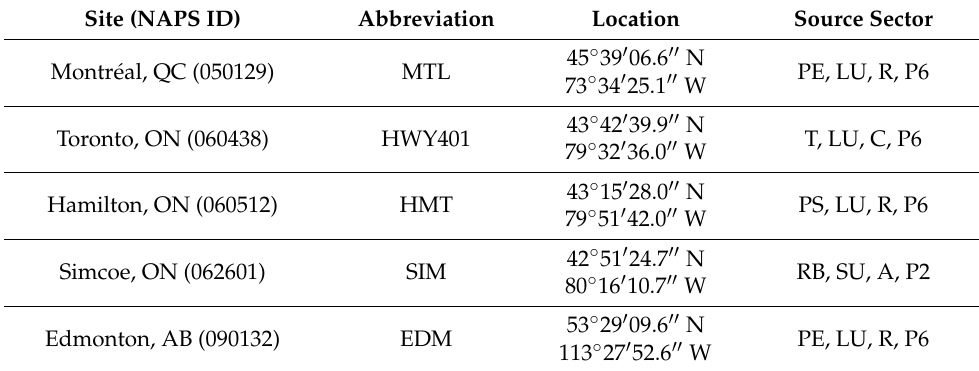
Table 1. Description of the NAPS sampling